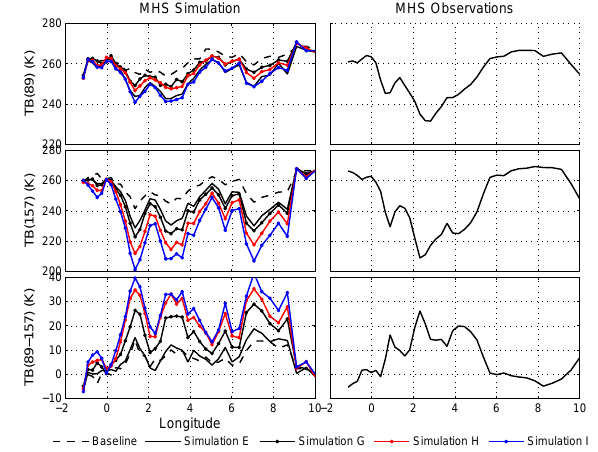
Figure 6. The observed (right) and the simulated (left) brightness temperature measurements from the MHS windows channels along the transect of interest presented in Fig. 5. See Table 2 for more information on each of the simulations